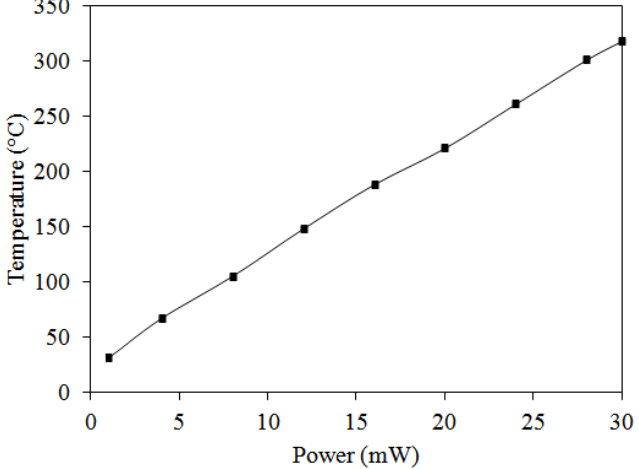
Figure 9. Measured results of the working temperature generated by the